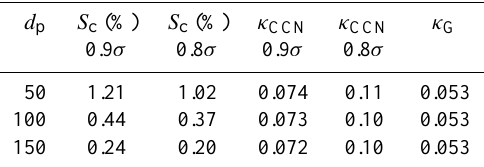
Table 4. Hygroscopicity parameters derived from CCN properties ( κ CCN ) and hygroscopic growth factors ( κ G ) for a particle consist- ing of levoglucosan and succinic acid in varying proportions. The respective values of S c and GF used in the calculations can be found in Table